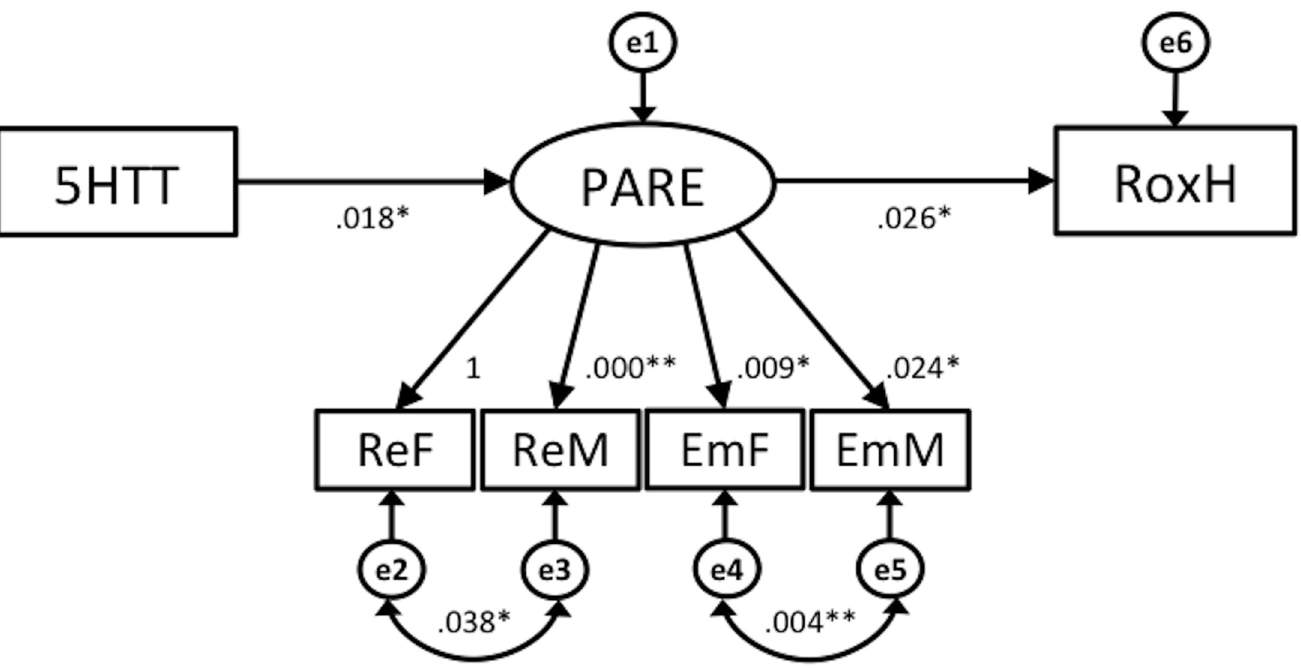
Fig 7. Structural Equation Model 2. Note: All paths significant ( ** p < .001 * p < .05) unless indicated (ns). 5HTT = 5-HTTLPR, PARE = Perceived parenting style (ReF = Paternal Rejection, ReM = Maternal Rejection, EmF = Emotional warmth from father, EmM = Emotional warmth from mother), RoxH = Right frontal oxygen